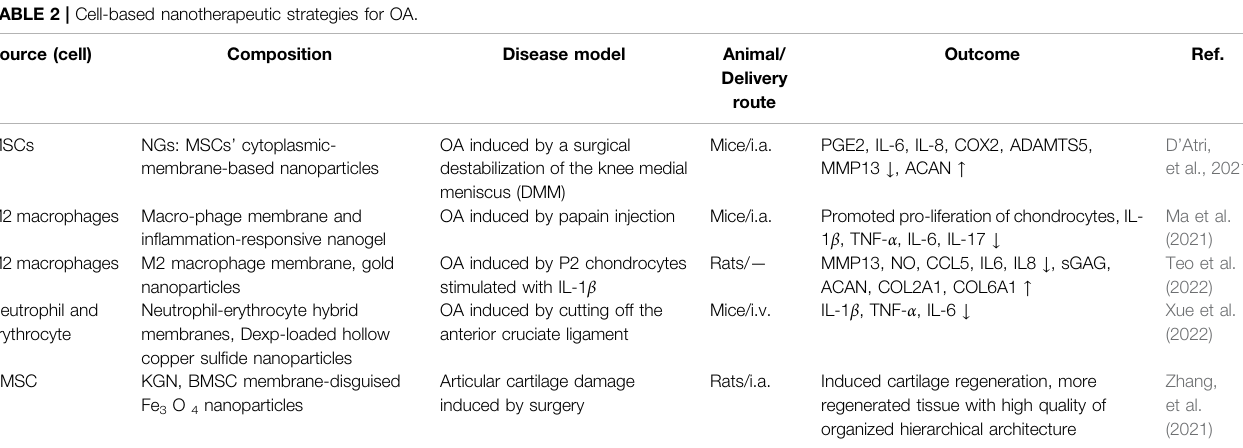
TABLE 2 | Cell-based nanotherapeutic strategies for OA. Source